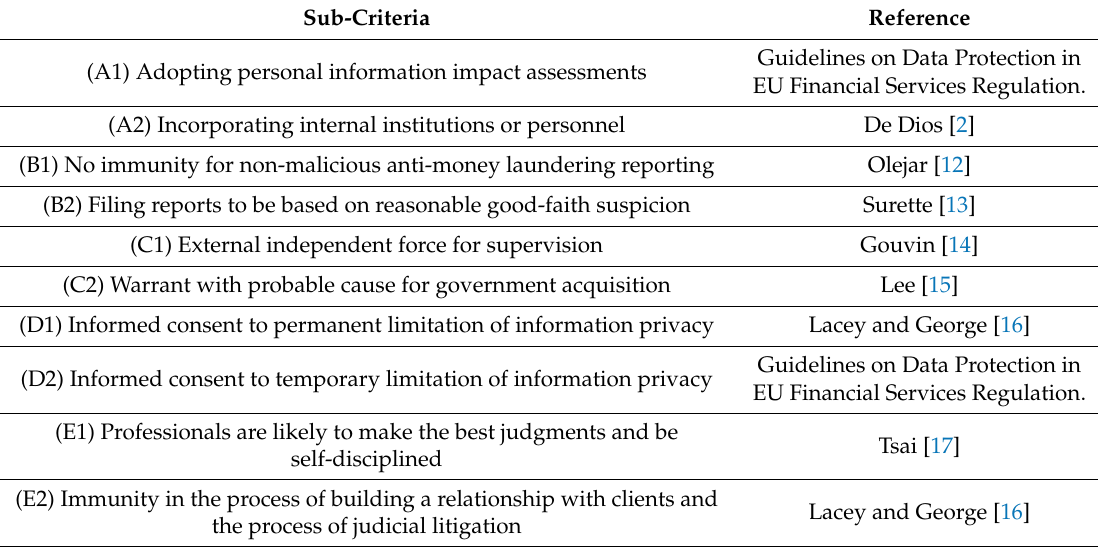
Table 2. Sub-criteria to be considered in the analytic hierarchy